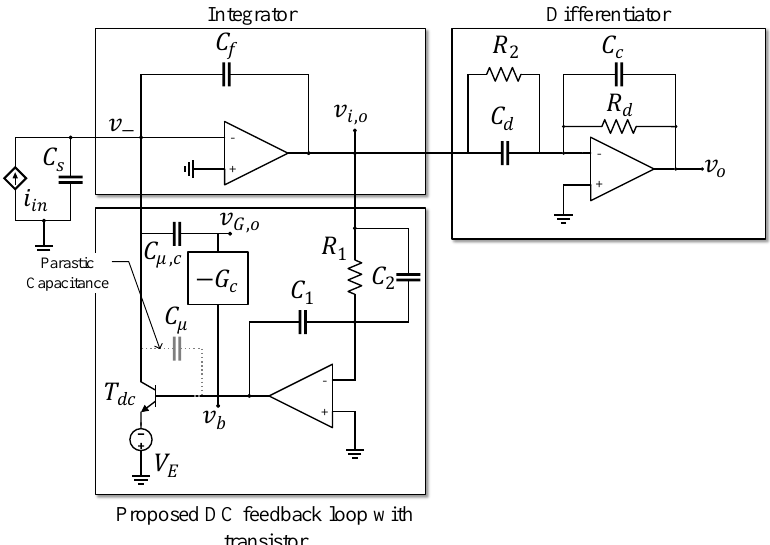
Figure 2. Capacitive Feedback Transimpedance Amplifier with the proposed DC feedback loop with a